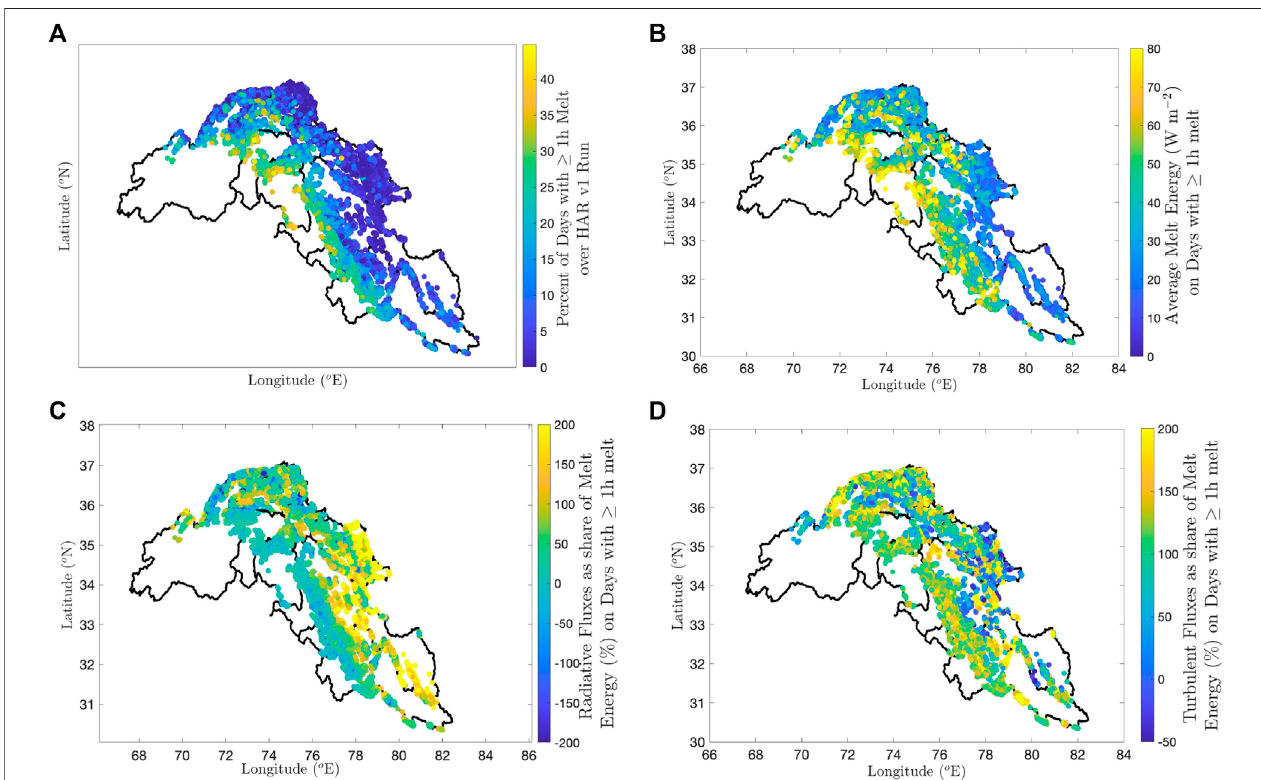
FIGURE 4 | Map of the Upper Indus Basin showing (A) percent of days with at least 1 hour of melt, and, on those days, (B) average melt energy. (C,D) show the percentsofthataveragedailymeltenergycomprisedofradiativeandturbulent fl uxes,respectively.Thecomponentpercentsaddto100andmayindividuallyhavevalues less than 0orexceeding100.Forscale, referto Figure1 .Note thatthese fi gures are notprojected intoacoordinate system butrather showtheUpper Indus Basinwith linear spacing of latitude and longitude on the axes. The model runs span 2001 – 2013.